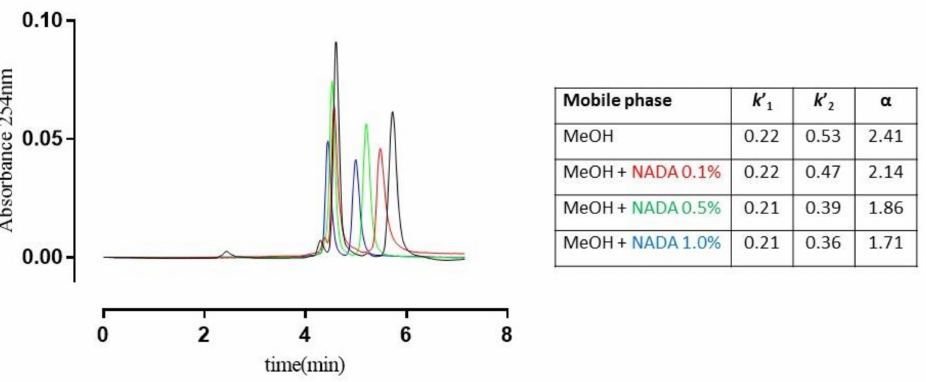
Figure 5. Superposition of chromatograms of ( ± )- 6 on TAG-based CSP using MeOH 100%, v / v as the mobile phase containing increasing concentrations of N -acetyl- D -Ala (NADA). Retention factors of the first and second eluted enantiomers ( k ’ 1 and k ’ 2 ), and separation ratios ( α ) are summarised in the table; flow rate: 0.7 mL · min − 1 ; room temperature; UV detection: 254 nm.